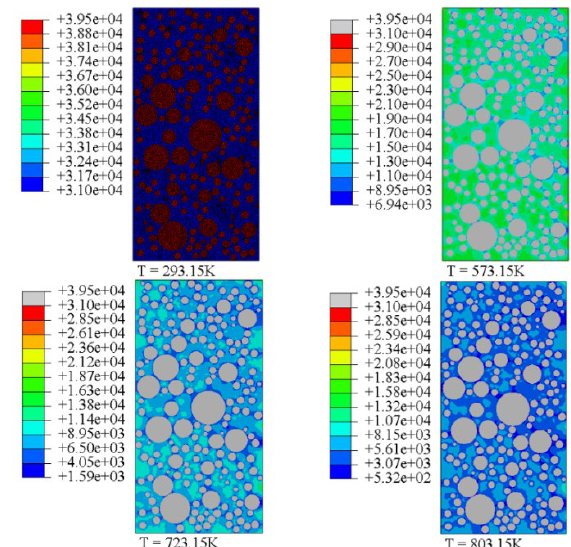
Figure 12. Young's module map, in MPa, for 293.15, 573.15, 723.15 and 803.15